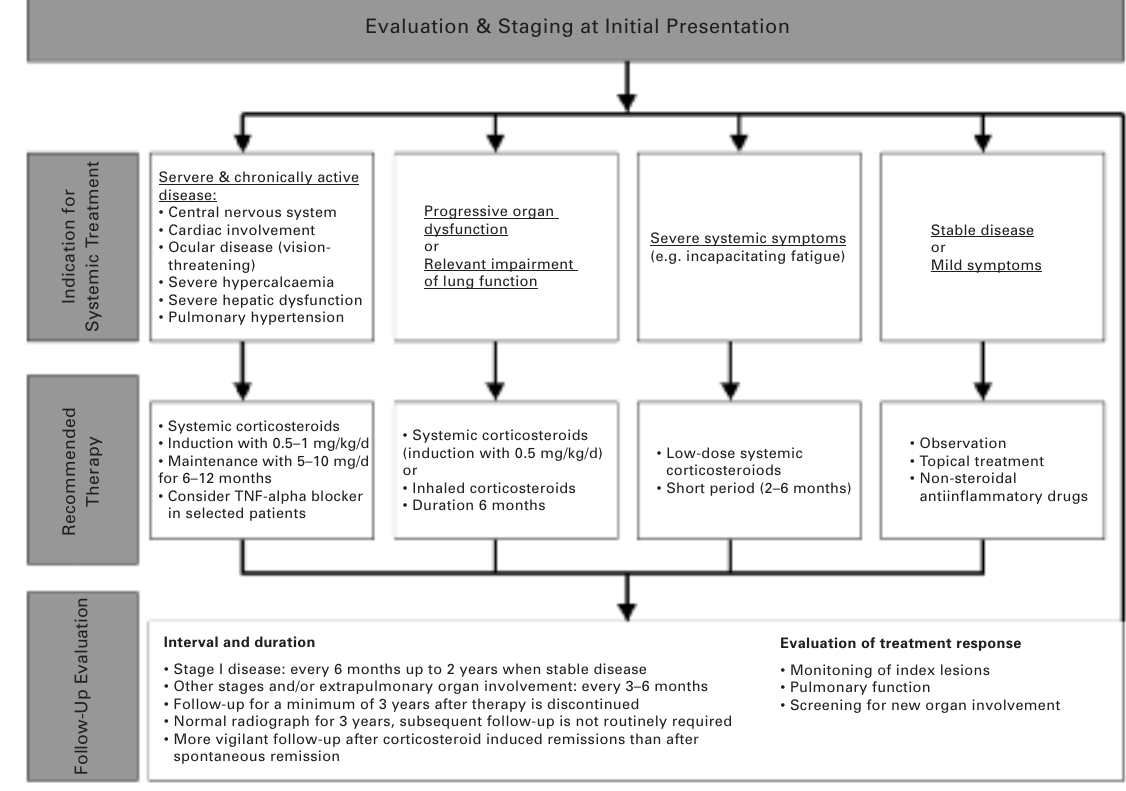
Figure 2 Therapeutic ap- proach of a patient with sarcoidosis (adapted from Thomas and Hun- ninghake 2003 [5] and Costabel 2001 [61]). In general, only patients with severely active and/ or progressive dis- ease should receive systemic